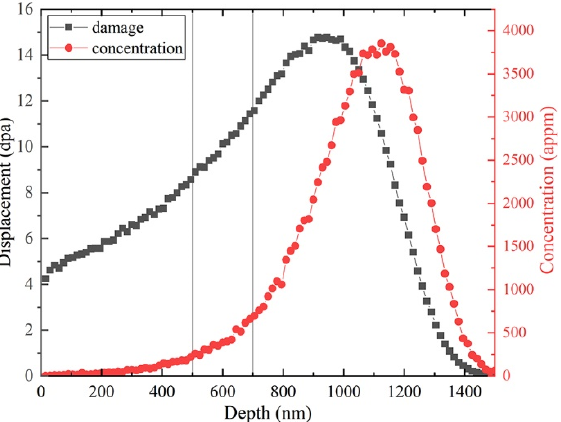
Figure 1. SRIM calculation of displacement damage and ion concentration distribution in 3.2 MeV Fe ions-irradiated FeCrAl